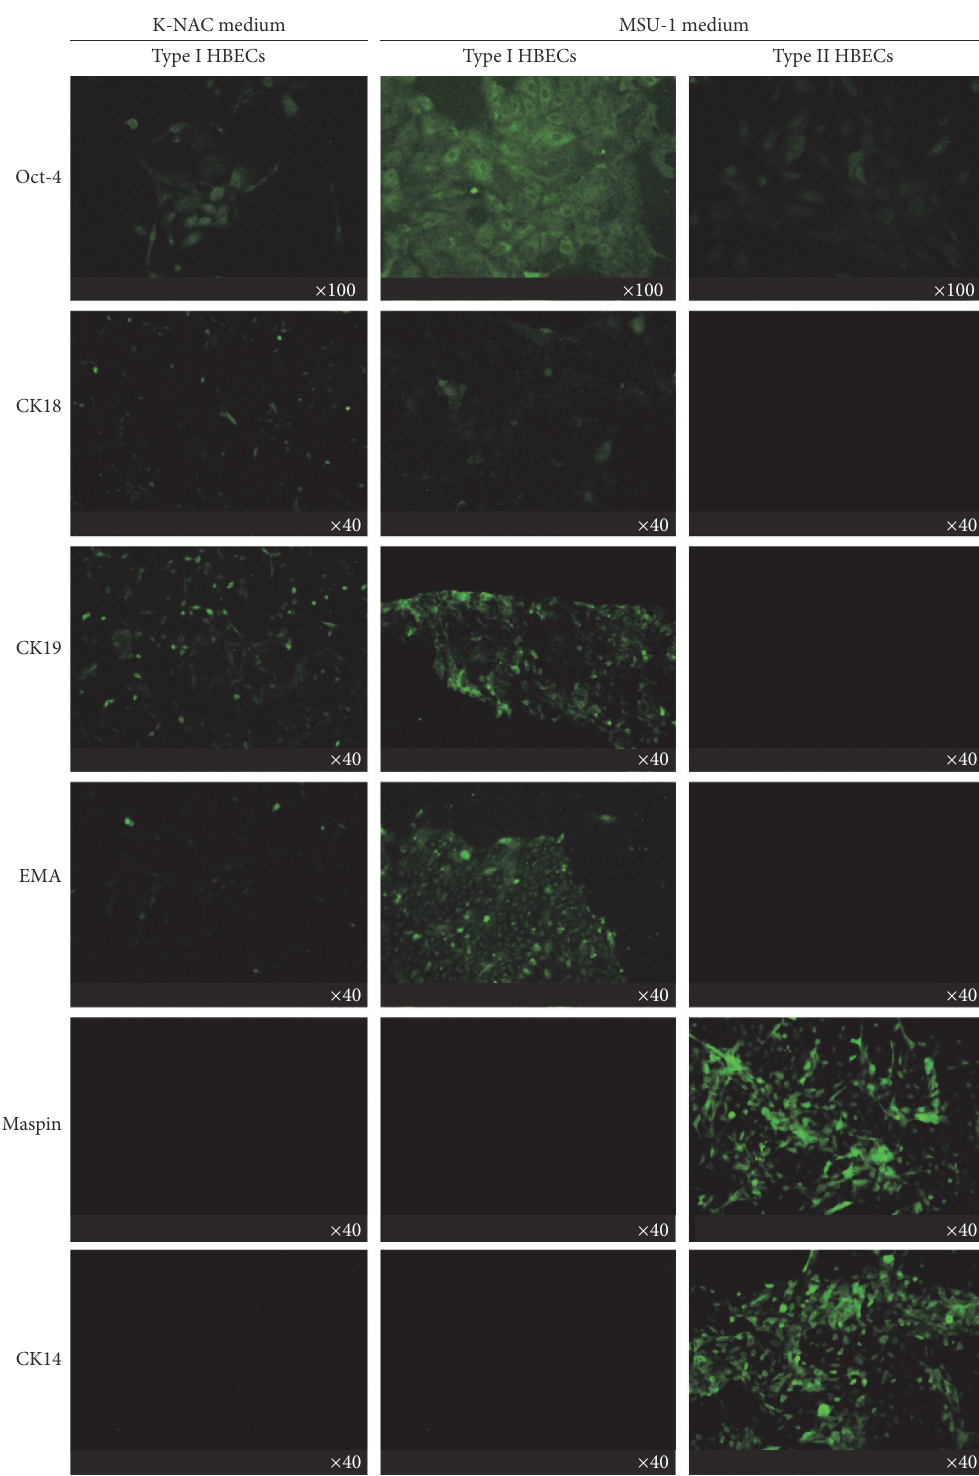
Figure 4: By immunostaining, Type I HBECs cultured in K-NAC and MSU-1 medium were found to express Oct-4, CK18, CK19, and EMA but not maspin and CK14. Type II HBECs expressed Oct-4, maspin, and CK14 but not CK18, CK19, and EMA as detected by